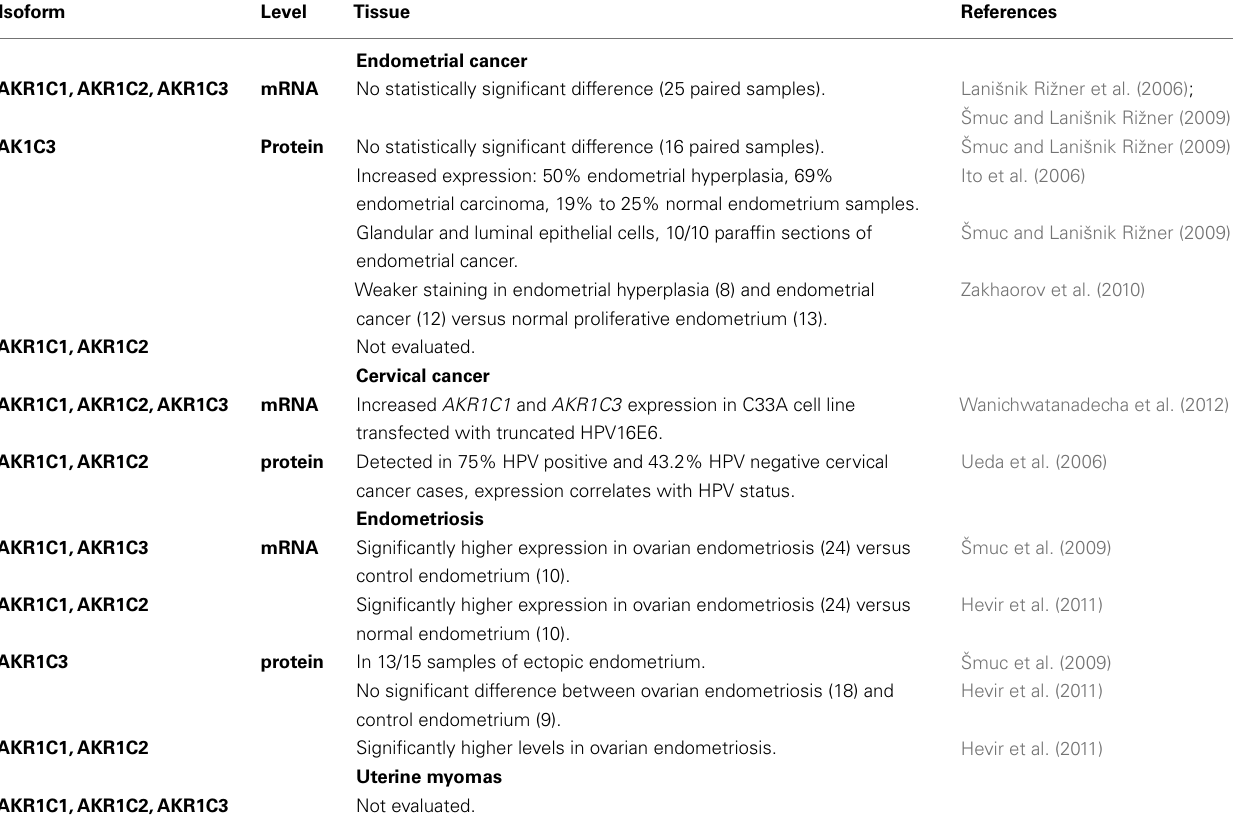
Table 6 | Expression of AKR1C1 , AKR1C2 , and AKR1C3 in uterine diseases